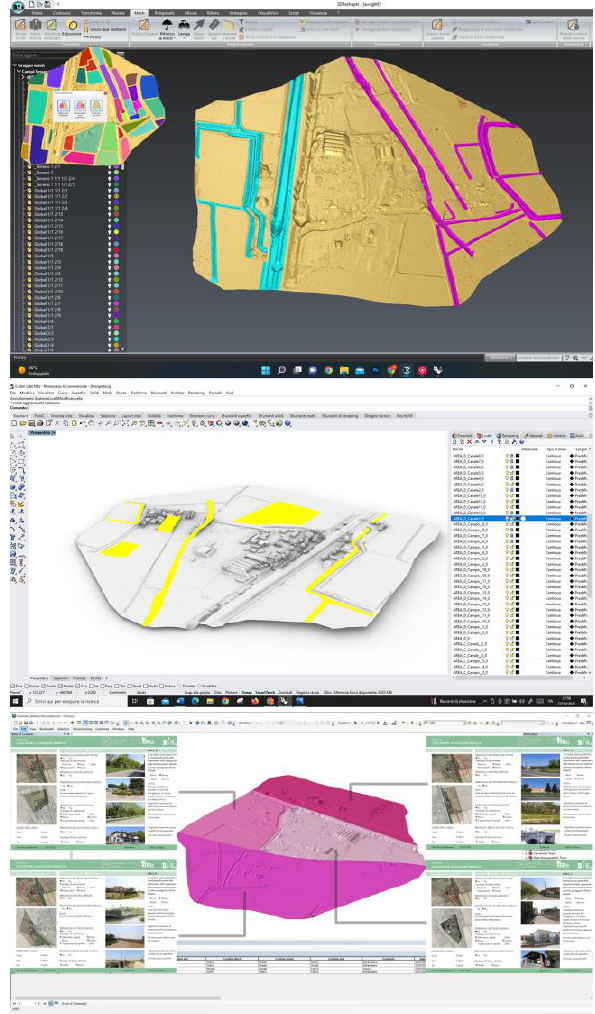
Figure 6 . Images of models and census integrated on an information system platform – ESRI